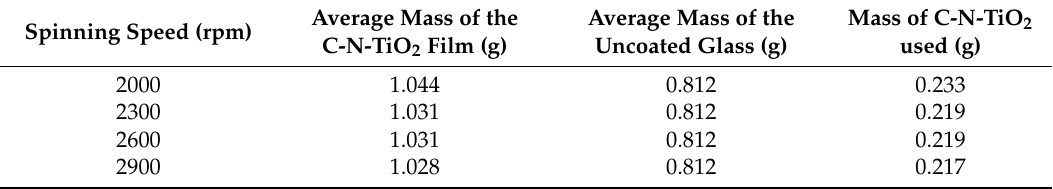
Figure 3. Effect of rotational coating speed on the annealed C-N-TiO 2 film thickness obtained at the following conditions: sol gel to solvent volume ratio ( V : V ) 3:5, spinning time 90 s. The samples were pyrolyzed in N 2 at 350 °C (ramping rate of 10 °C/min) for 105 min. The thickness measurements of each film were duplicated ( n = 2). Table 2. Mass (g) of C-N-TiO 2 deposited on films coated at different spinning speeds at the following conditions: sol gel-solvent volume ratio ( V : V ) 3:5, coating time 90 sec. The samples were thereafter